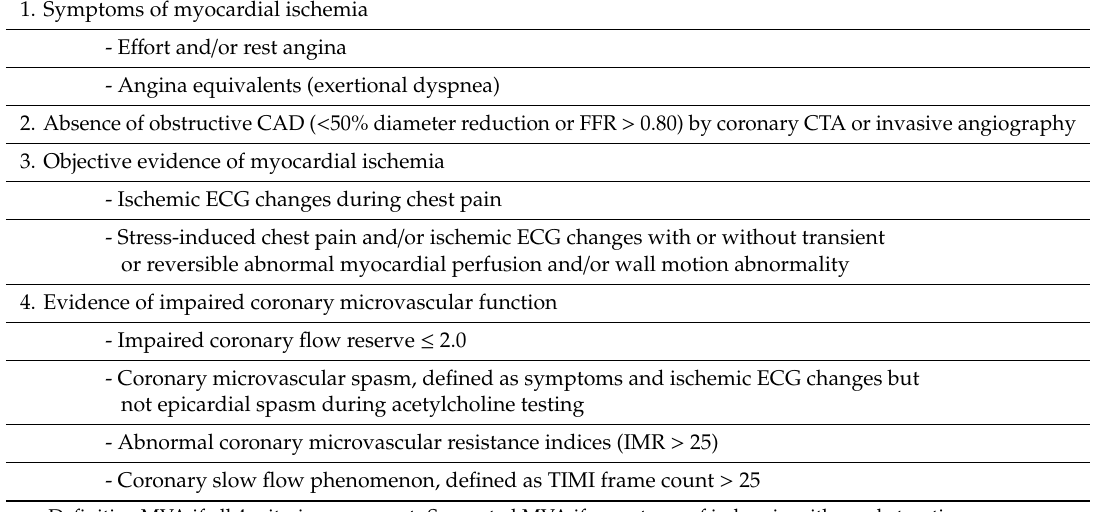
Table 1. Clinical criteria for the diagnosis of microvascular angina